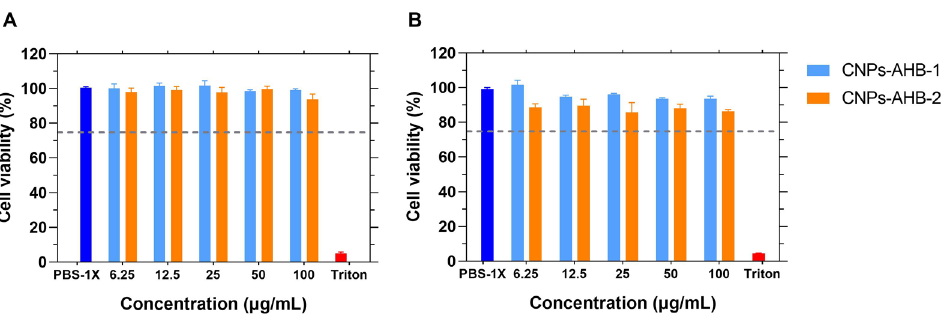
Figure 10. Cell viability of free peptides and CNPs-peptide nanobioconjugates in Vero cells by the MTT assay. ( A ) Percentage of viable cells after 24 h of exposure to the treatments. ( B ) Percentage of viable cells after 48 h of exposure to the treatments. Cell viability remained above 85% when exposed to CNPs-peptide nanobioconjugates. PBS-1X was used as negative control and Triton X-200 0.2% ( v/v ) as positive control.